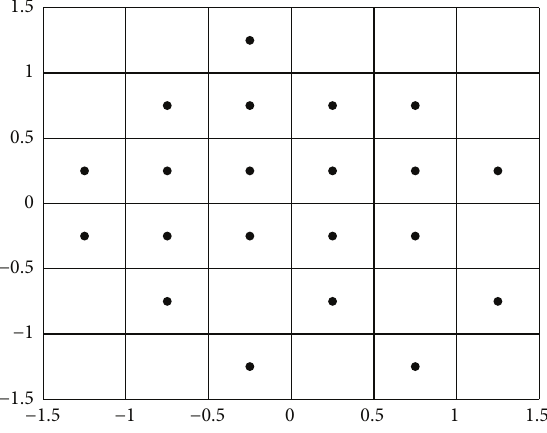
Figure 3: Array configuration for 21 elements.